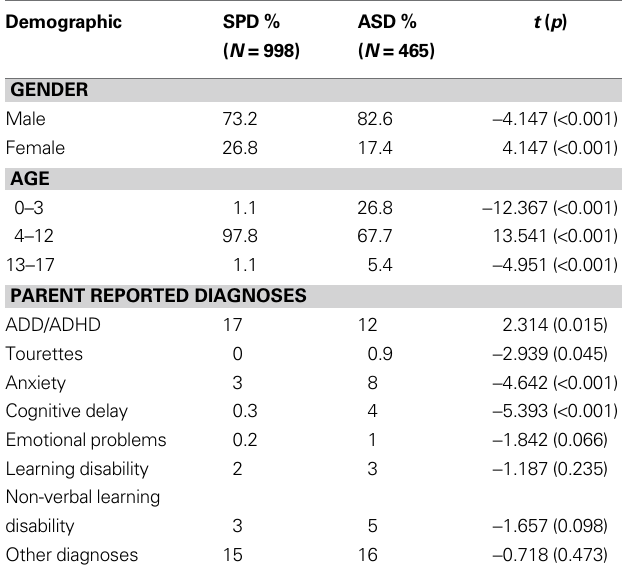
Table 1 | Gender, age, and diagnoses of SPD and ASD groups: percentage, valid N , and T -tests between